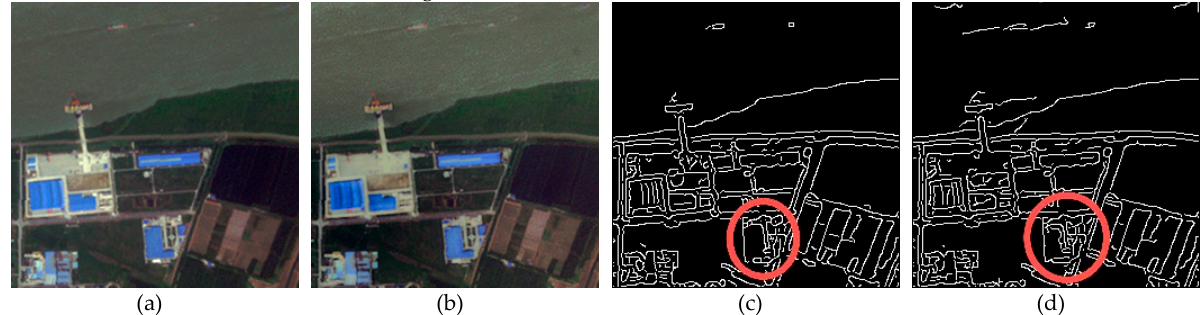
Figure 9. Edge detection of optical image and fused image. ( a ) Optical image; ( b ) fused image; ( c ) edge detection of optical image; ( d ) edge detection of fused image.